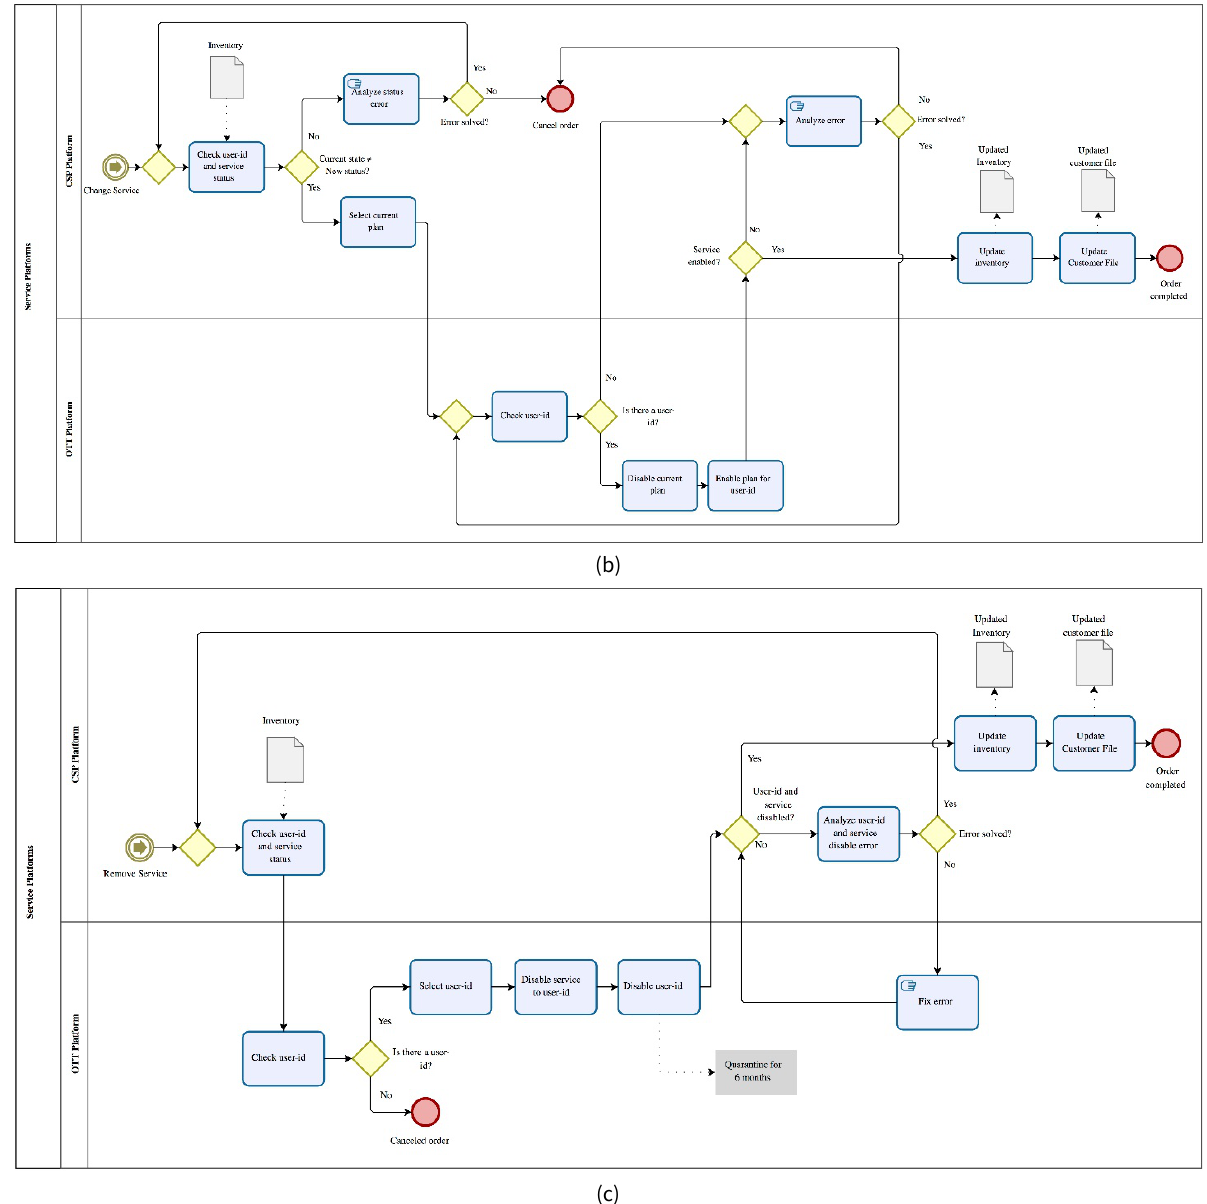
Figure 5. Level 4 - “Order-to-Payment” Service Processes (Level 4): (a) Add Service; (b) Change Service; (c) Remove